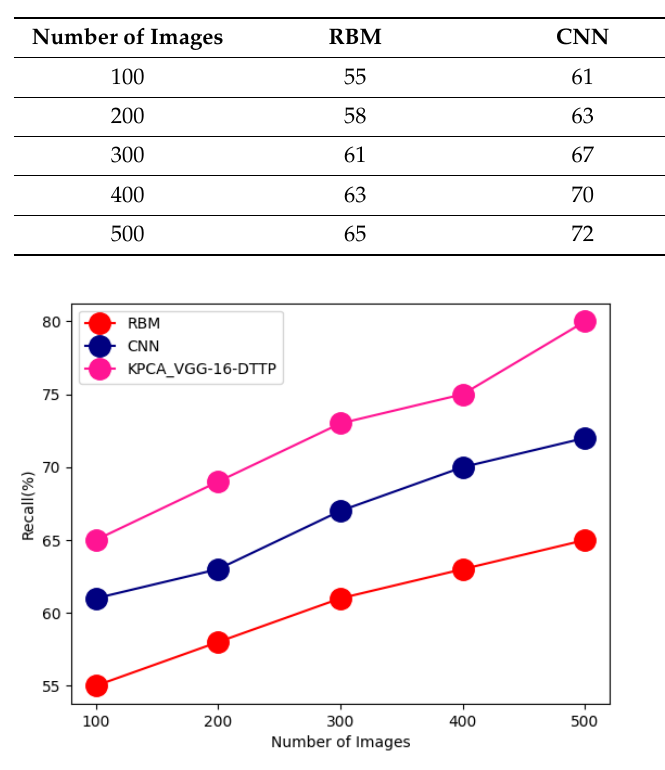
Table 5. Comparative analysis of RMSE.